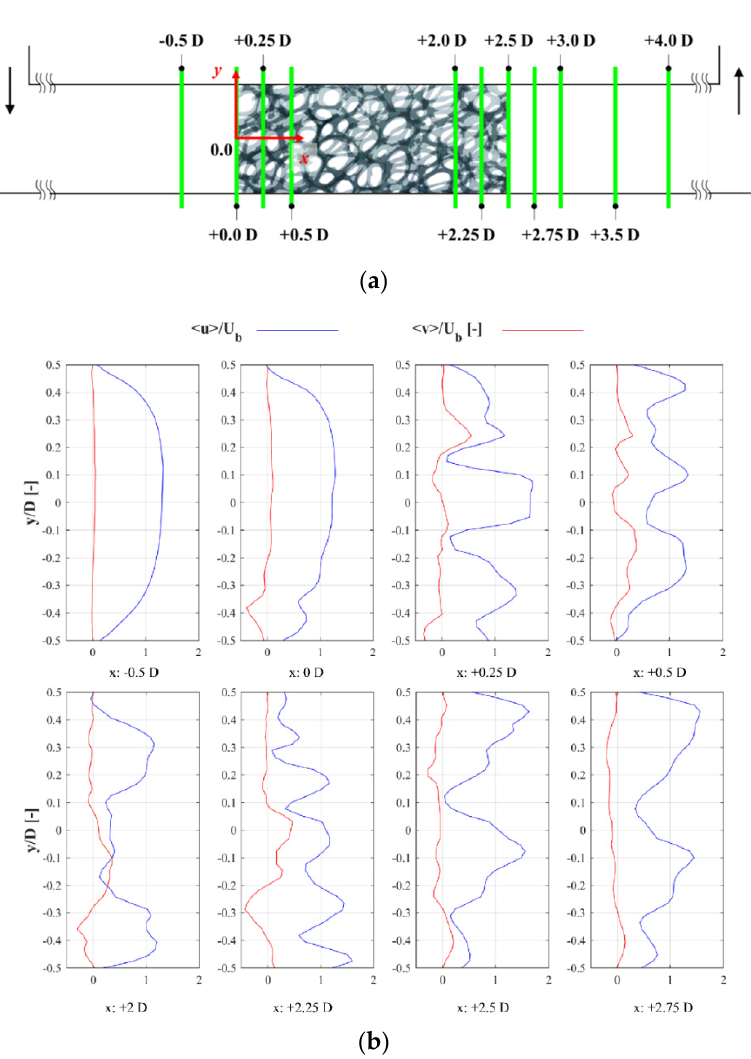
Figure 8. ( a ) Mean velocity plot location in the test section; ( b ) mean velocity